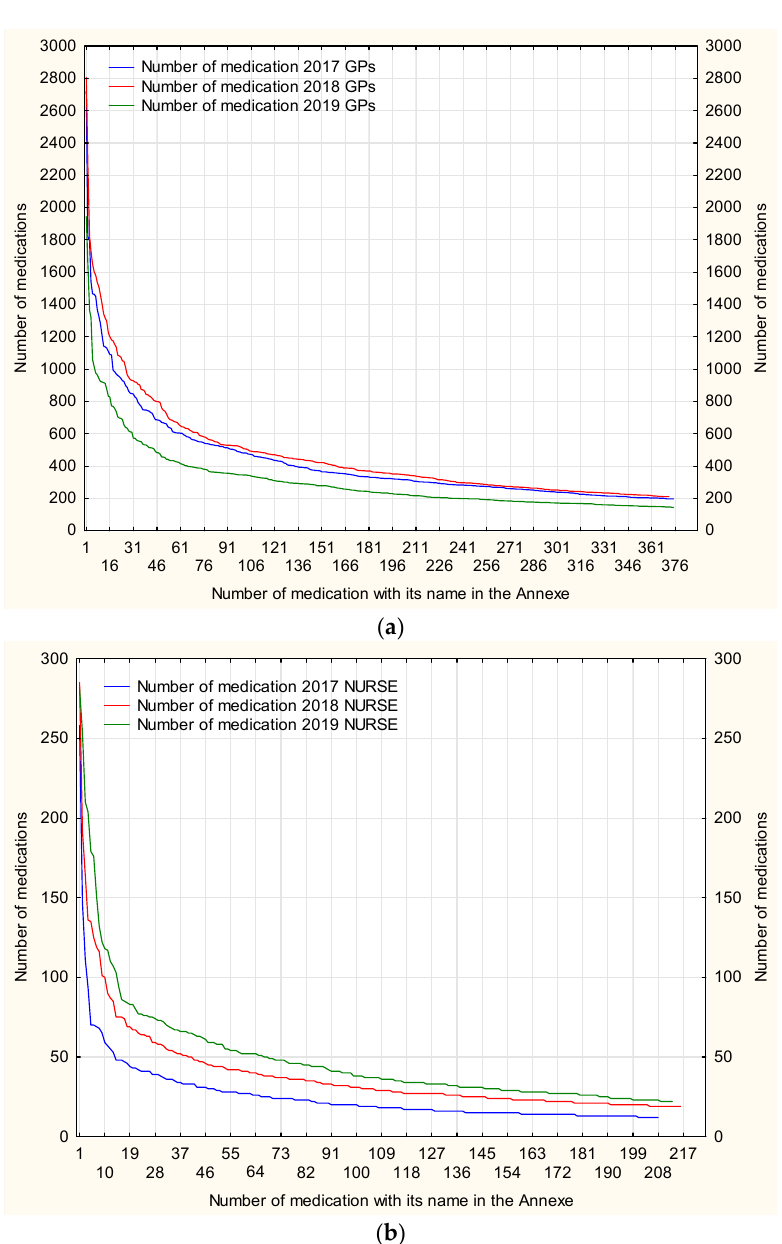
Figure 14. The number of the most common medications prescribed by the nurse ( a ) or GP ( b ) per